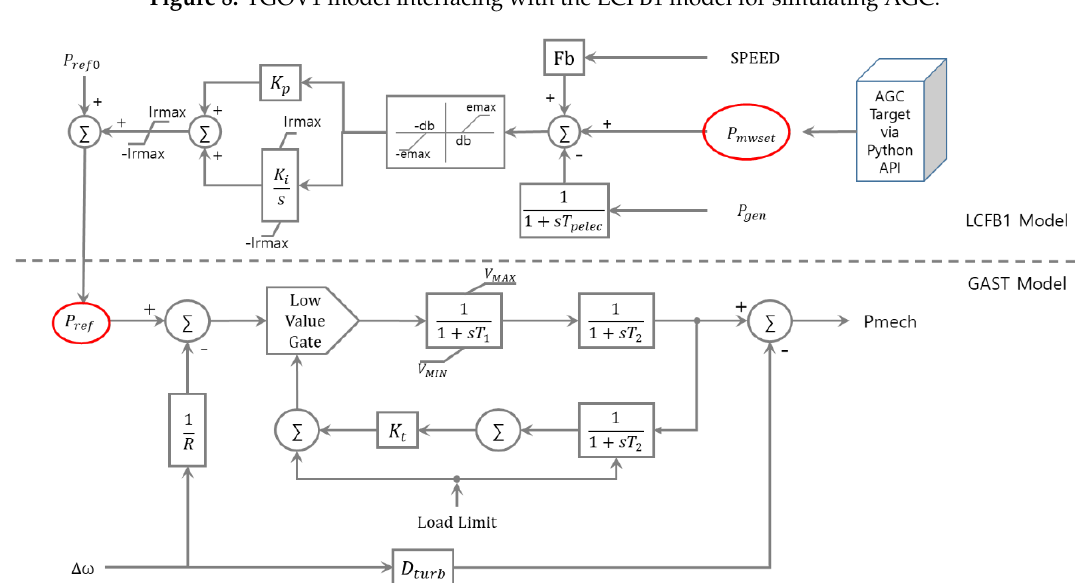
Figure 9. GAST model interfacing with the LCFB1 model for simulating AGC.